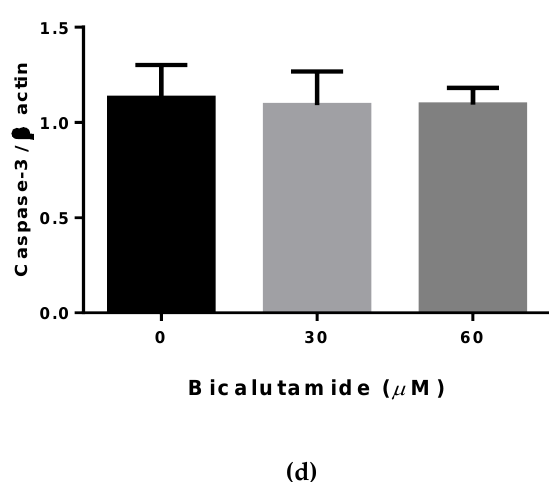
Figure 6. Expression and the quantitation of BCL2/adenovirus E1B 19 kDa protein-interacting protein 3 (BNIP3), cleaved-caspase-3 and caspase-3 in rat mesangial cells (RMCs) after being treated with bicalutamide (Bic) at 30 and 60 μM for 24 h. Total RMC lysates were loaded onto Western blots for analysis of BNIP3, caspase-3, cleaved caspase-3 and β -actin. β -actin served as the internal control. ( a ) Western blot of BNIP3 and cleaved caspase-3. ( b ) Bar diagram of BNIP3. ( c ) Bar diagram of cleaved caspase-3. ( d ) Bar diagram of caspase-3. Cleaved caspase 3 was significantly upregulated at 24 h after treatment. In contrast, caspase-3 was unaffectd ( d ). Data were obtained from triplicate determinations and results are expressed as the mean ± standard deviation. * p < 0.05, ** p < 0.01 compared to the control.